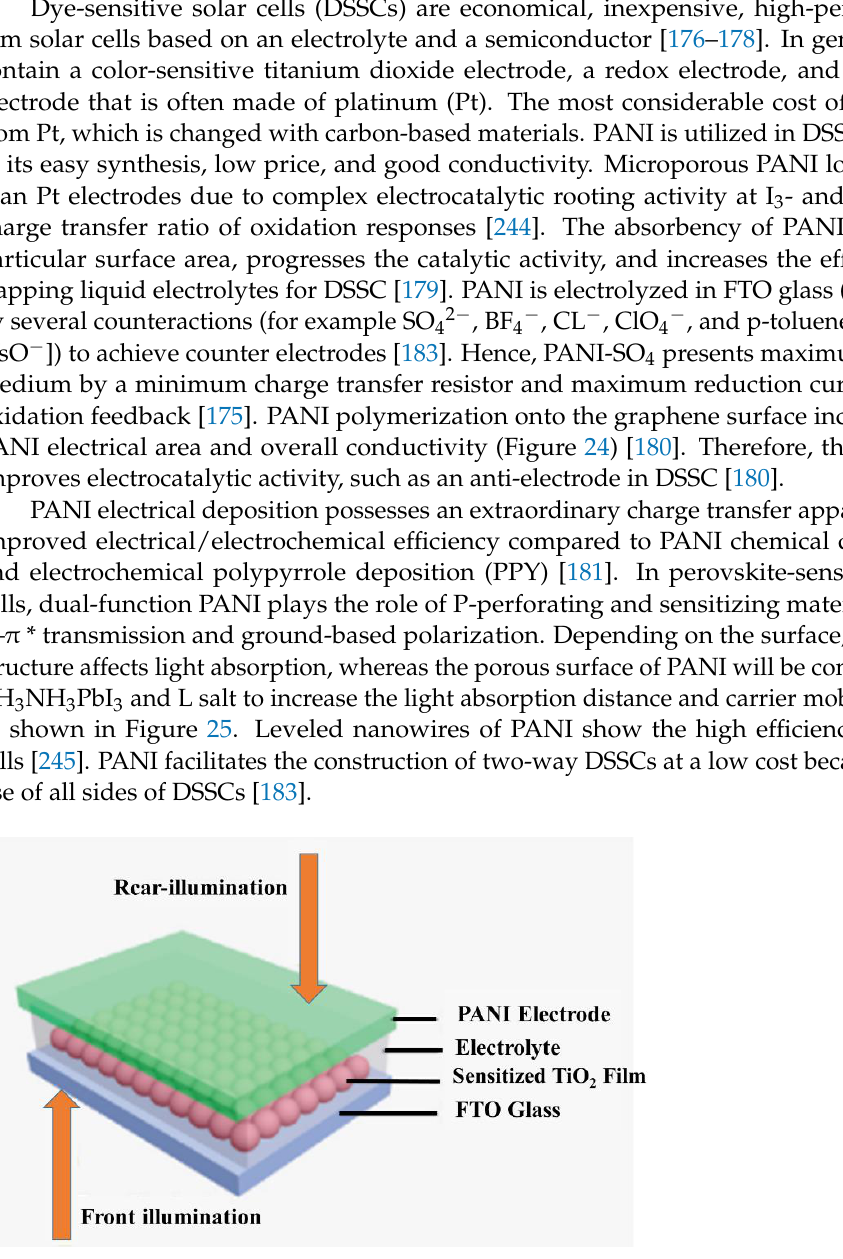
Figure 23. Schematic of the bifacial DSSC related to transparent PANI counter electrode. Reprinted with permission from Tai, Q.; Chen, B.; Guo, F.; Xu, S.; Hu, H.; Sebo, B.; Zhao, X.-Z. In situ prepared transparent polyaniline electrode and its application in bifacial dye-sensitized solar cells.